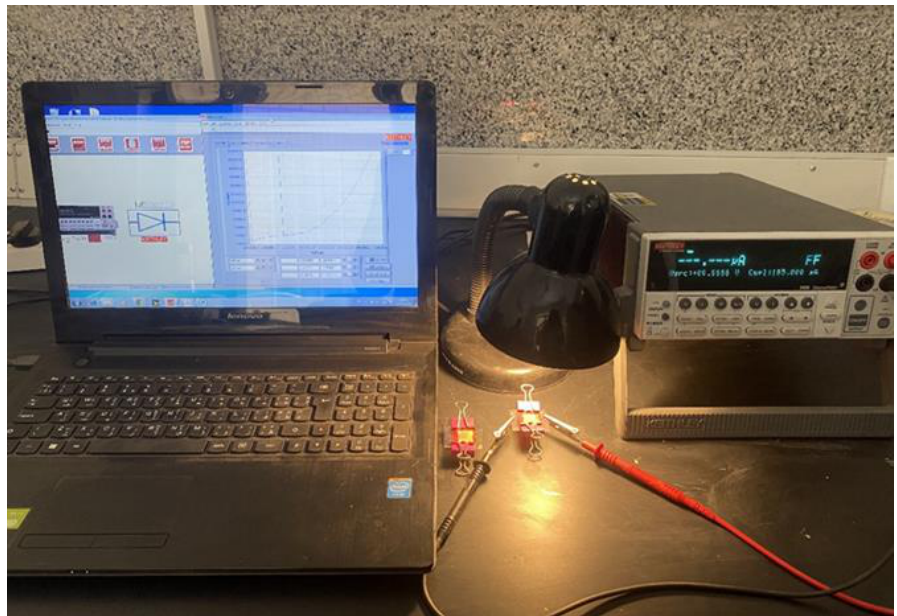
Figure 6. Photograph of solar cell measurement configuration.